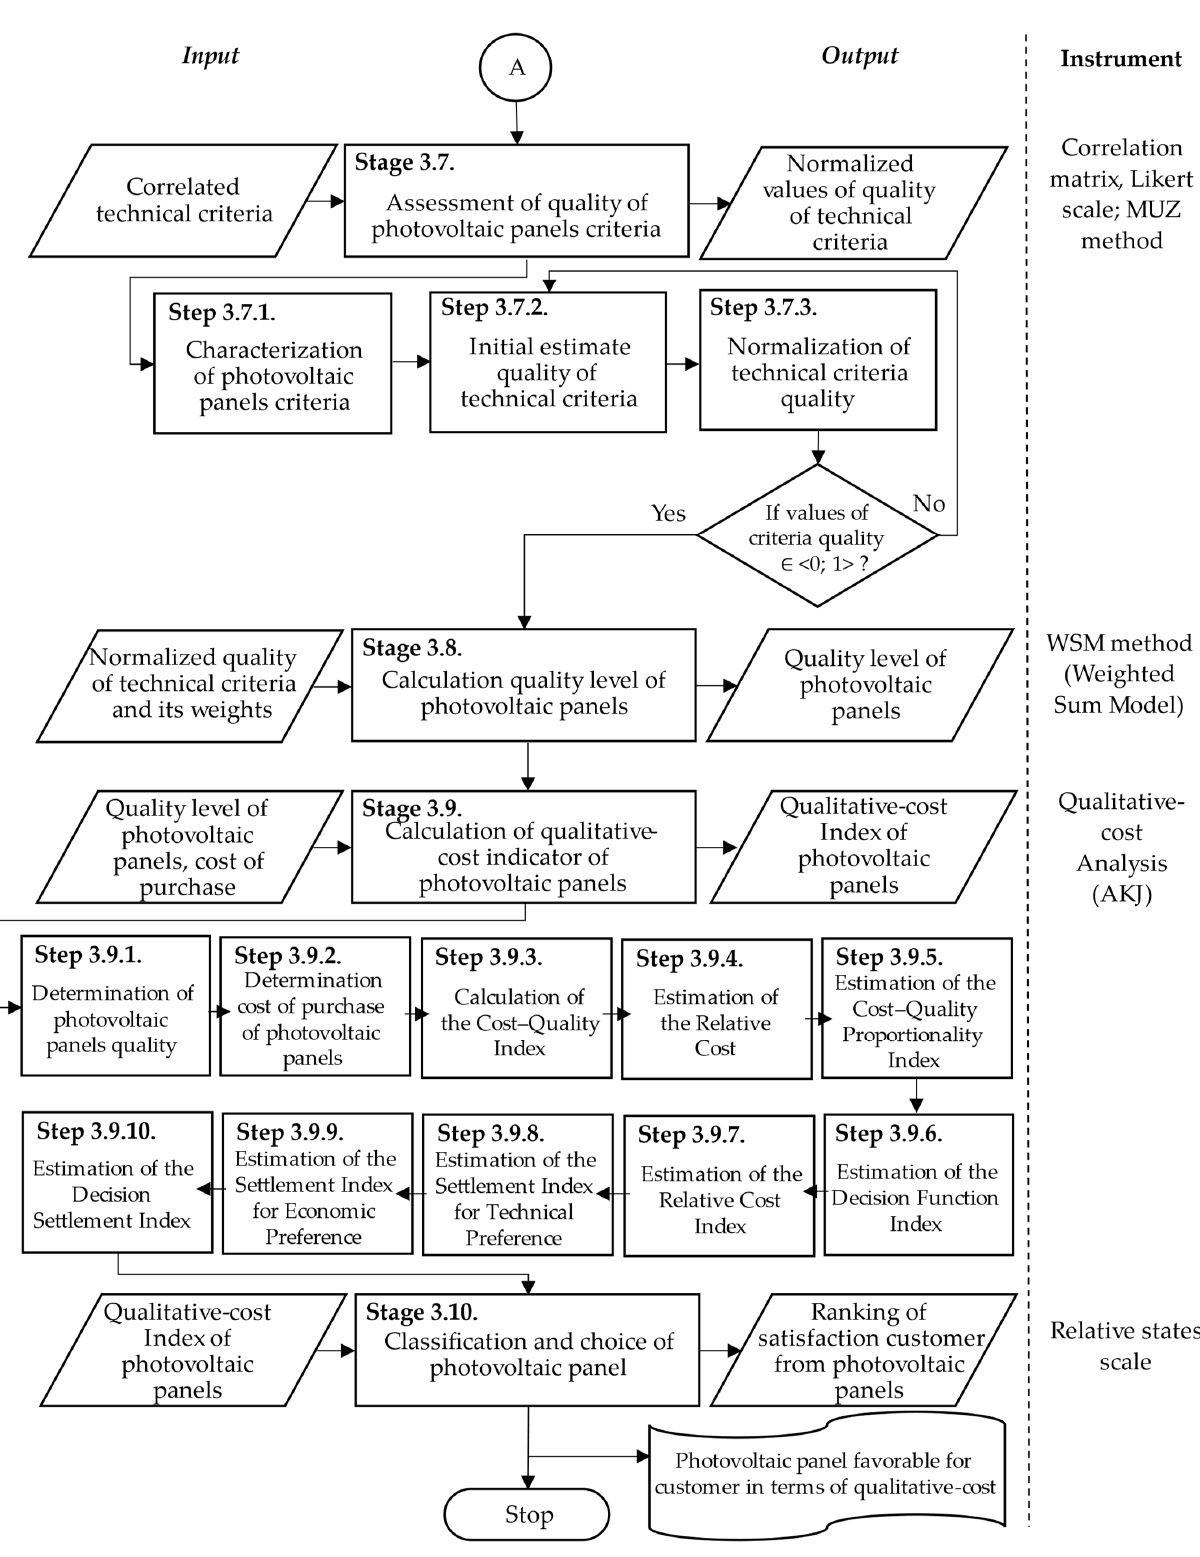
Figure 3. Model of choosing the most favorable photovoltaic panel—part 2. Own study.